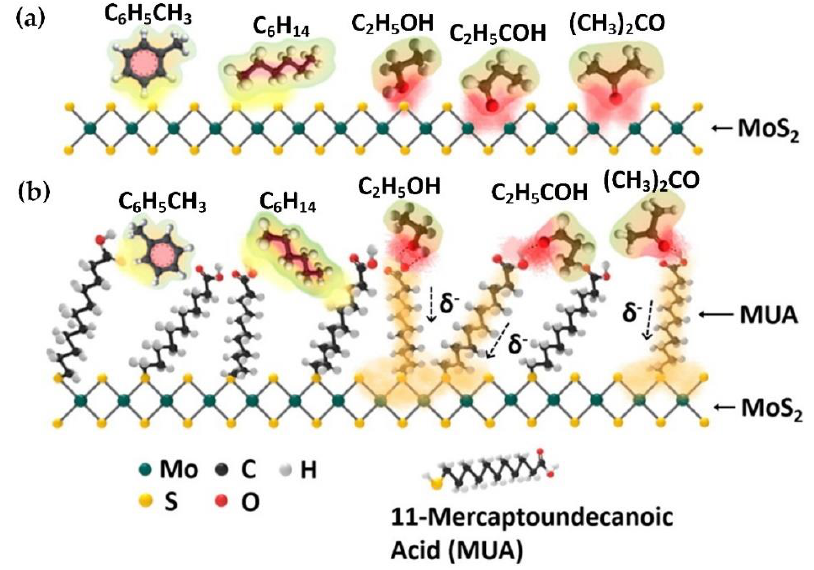
Figure 4. ( a ) Gas sensing mechanism for volatile organic compounds (VOC); toluene, hexane, ethanol, propanal, and acetone) gas molecule on primitive MoS 2 surface and ( b ) improved VOC sensing performance by Mercaptoundecanoic acid (MUA)-conjugated MoS 2 due to increased charge carrier density (Reproduced with permission from [160]. Copyright 2014 American Chemical